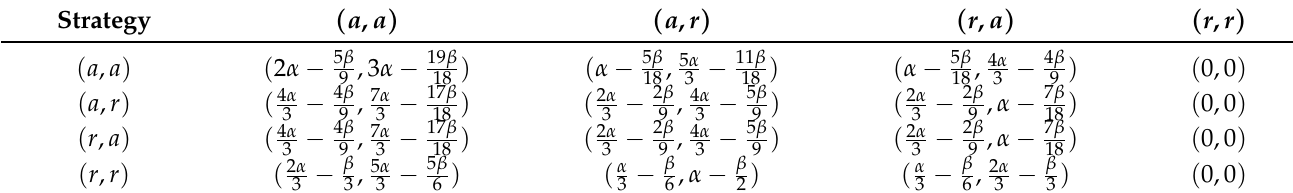
Table 3. Strategic form of subgame x Γ